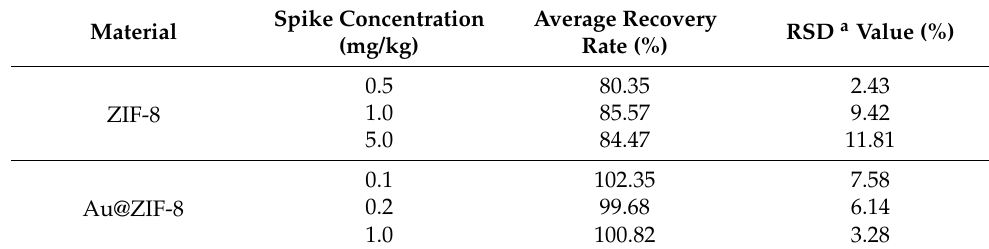
Table 2. The recovery and RSD of BPA.